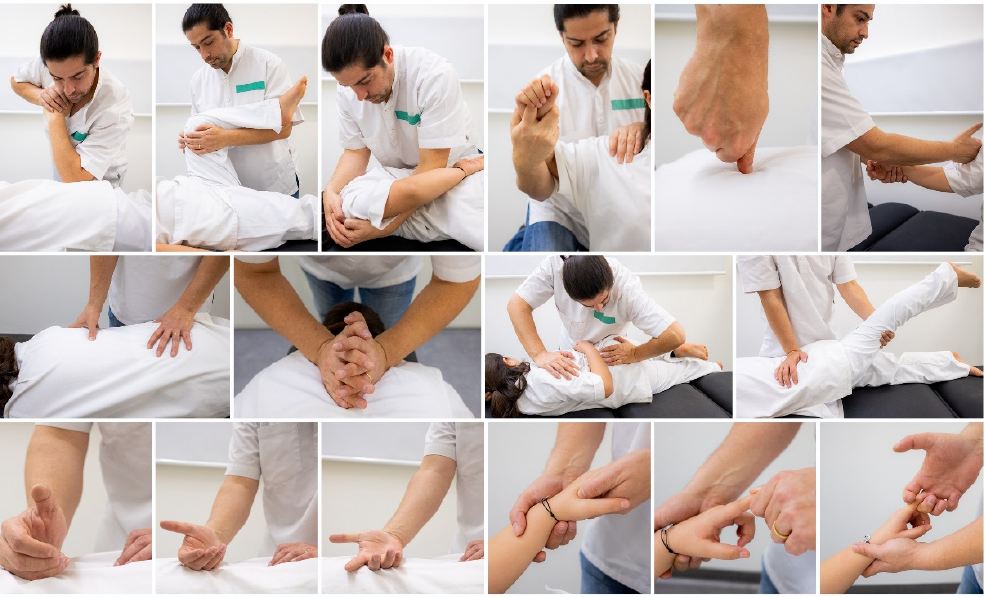
Figure 9. Examples of “Tuina” techniques used to treat various